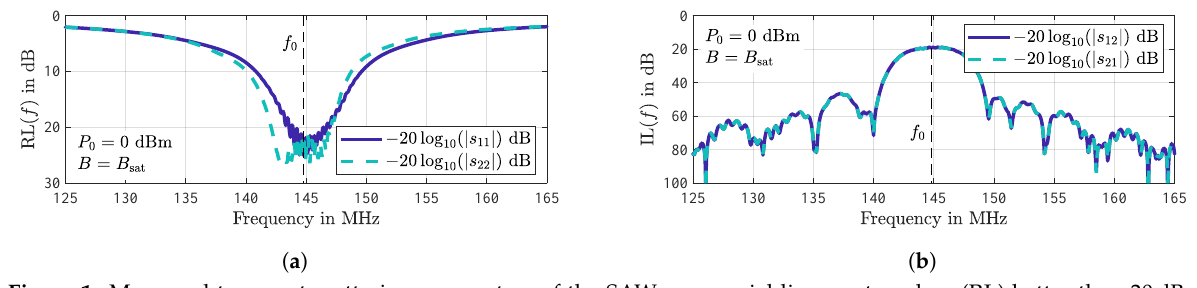
Figure 1. Measured two-port scattering parameters of the SAW sensor yielding a return loss (RL) better than 20dB at each port ( a ) and an insertion loss (IL) with a value of 20dB ( b ), both at the synchronous frequency of f 0 = 144.8MHz. During the measurements, performed for an input power of P 0 = 0dBm, the sensor has been magnetically saturated at B = B sat ≈ 10mT in order to avoid additional magnetic influences (which will be discussed below).